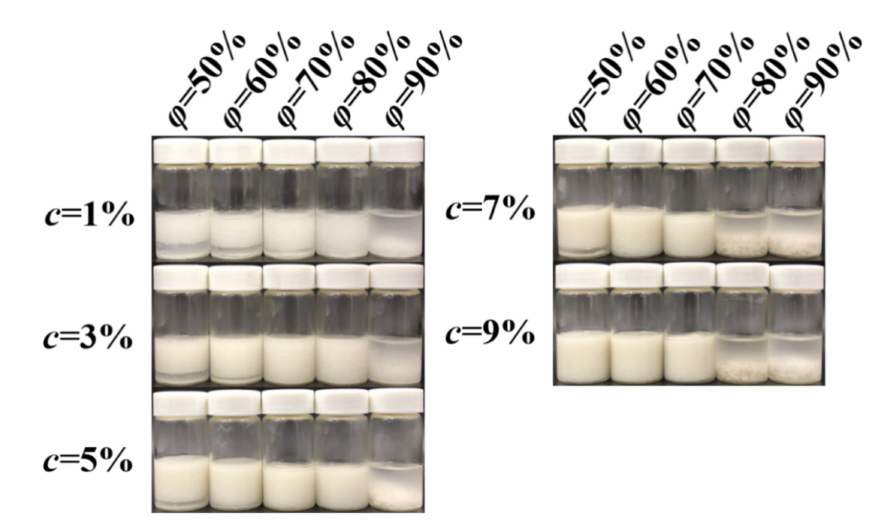
Figure 4. The formation of Pickering emulsions stabilized by sorghum flour.